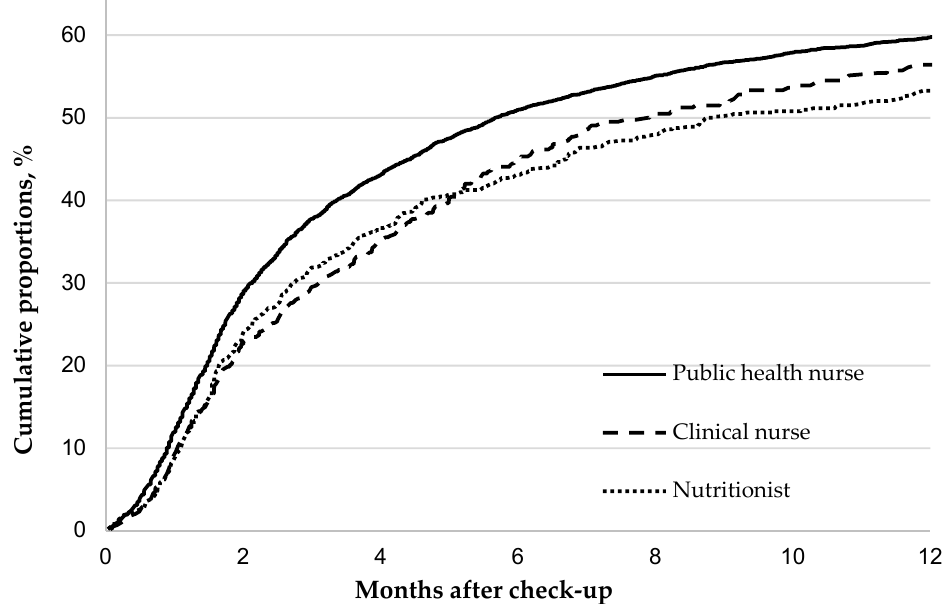
Figure 1. The cumulative proportions of clinic visits for participants according to health counselor’s profession.